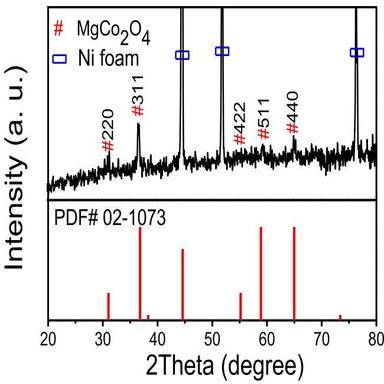
XRD patterns of the MgCo2O4 nanoneedle arrays/Ni foam, which corresponds to the standard diffraction pattern of MgCo2O4 (JCPDS card: No. 02-1073). The peaks generated by Ni are marked with rectangle signs.